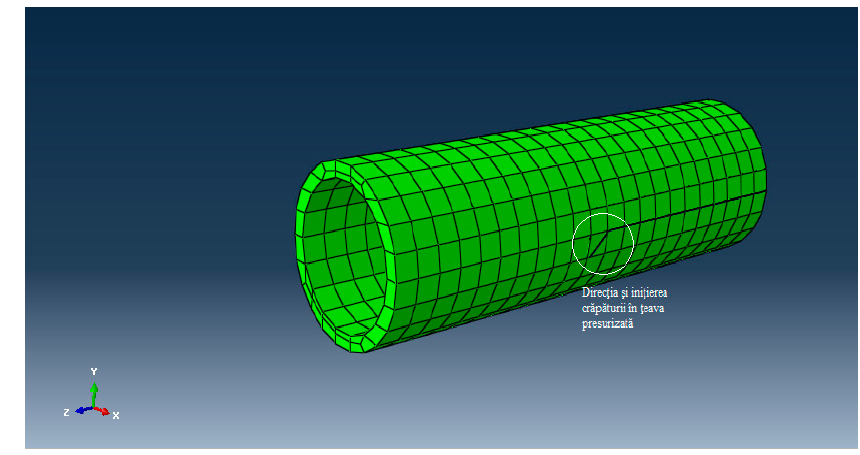
Figure 27. Crack analysis model of DN 315 pipe.